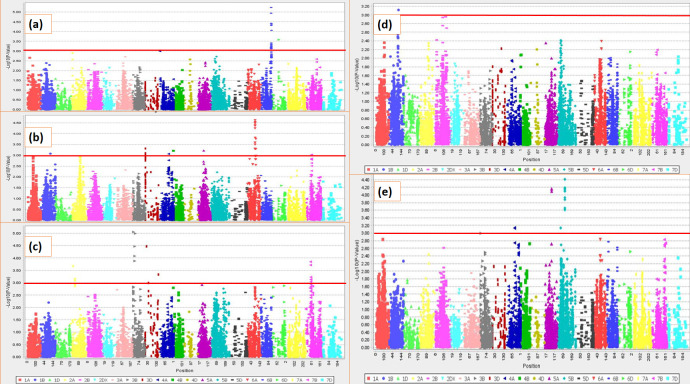
Manhattan plots for different traits under study: a) GI b) LM c) LP d) Ltn e) AUDPC. The threshold line at P = 0.001 has been drawn to highlight significant markers.